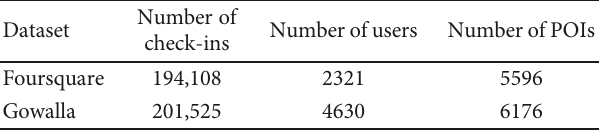
Table 2: Dataset statistics (after